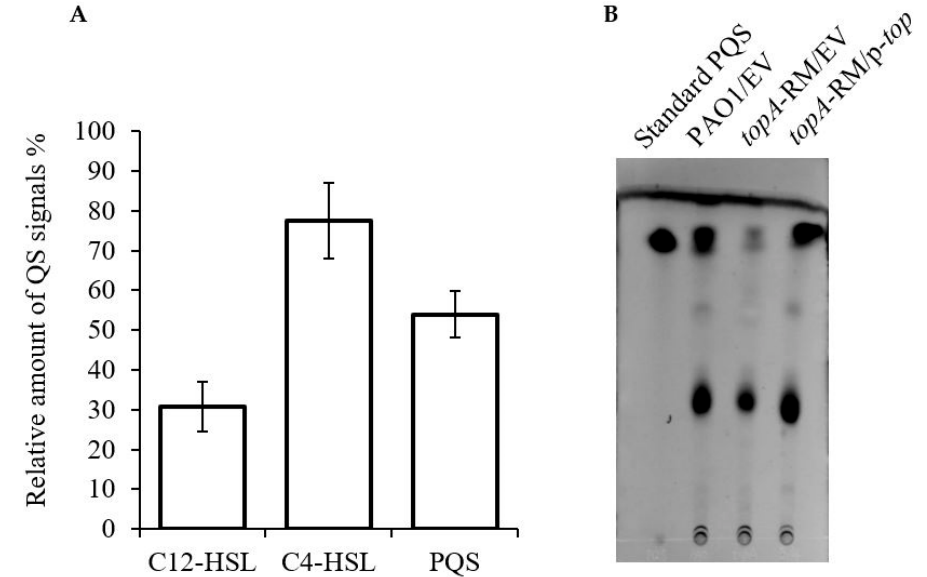
Figure 11. Relative amount of three QS signals in topA -RM compared with those in PAO1. ( A ) The relative amount of three signals in the culture supernatants of the two strains were measured using reporter systems. The relative percentage of signals was calculated by comparing the maximal cps values. The amount of each signal in PAO1 was designated as 100%. The means from three experiments are shown and the error bars represent standard deviations. ( B ) TCL analysis of PQS in the cultures of PAO1, topA -RM, and the complementation strain. PQS in the cultures was isolated by organic extraction and analyzed on TLC. Extract from 500 µ L of culture equivalent was loaded onto the TLC plate. EV: Empty vector control. p- topA: topA complementation construct.